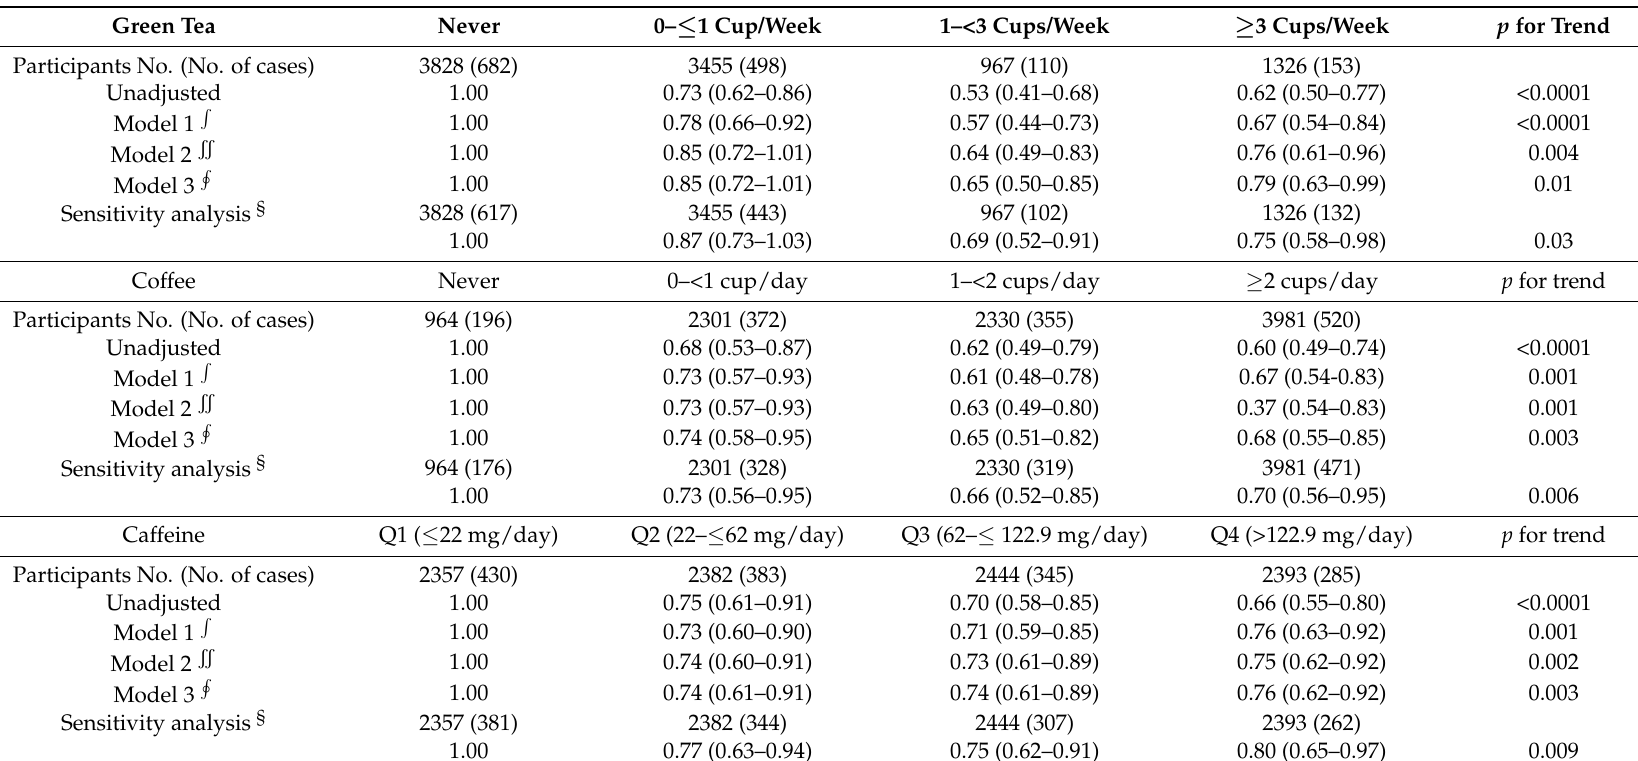
Table 4. Odds ratios (ORs) and 95% confidence intervals (CIs) of depression according to green tea, coffee and caffeine consumption ( n = 9576). Green